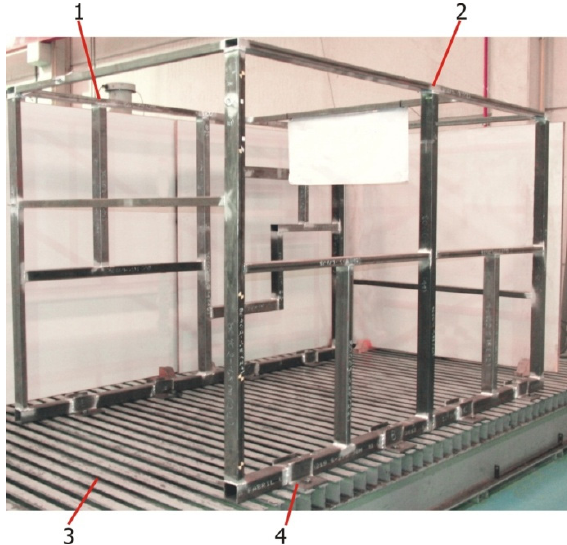
Figure 3. Tubular structure for the experimental validation.